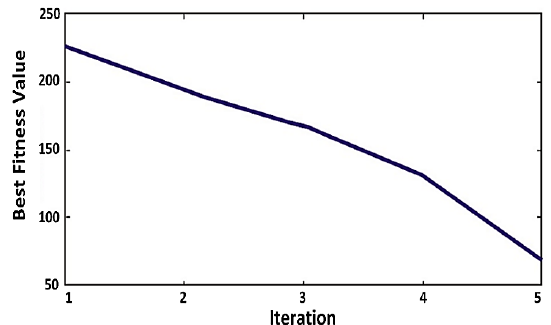
Figure 11. Reduction of best fitness values ( B opt ) with each progressing iteration caused by decreased battery values.